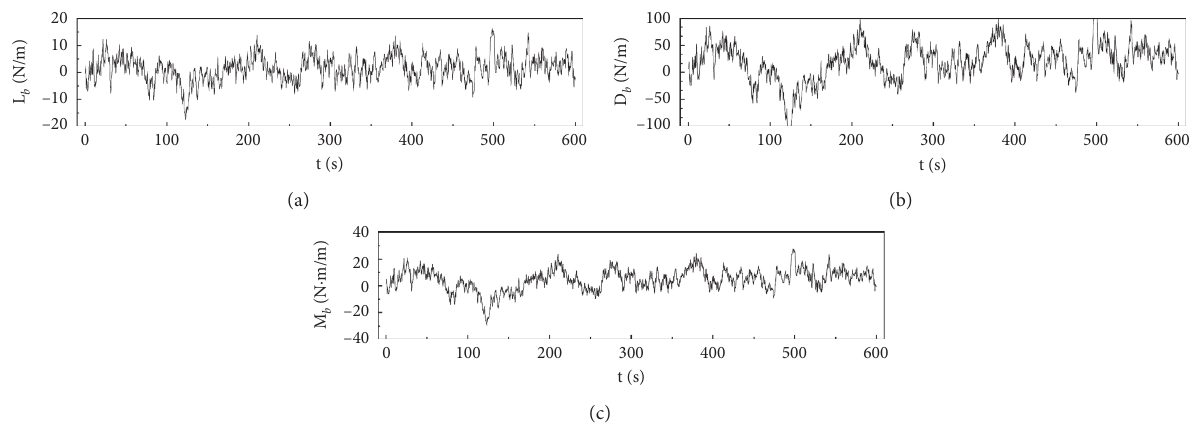
Figure 11: The simulated time histories of buffeting forces at the midspan (#15) of Case 1 at AoA of 0 ° : (a) buffeting lift force; (b) buffeting drag force; (c) buffeting pitching